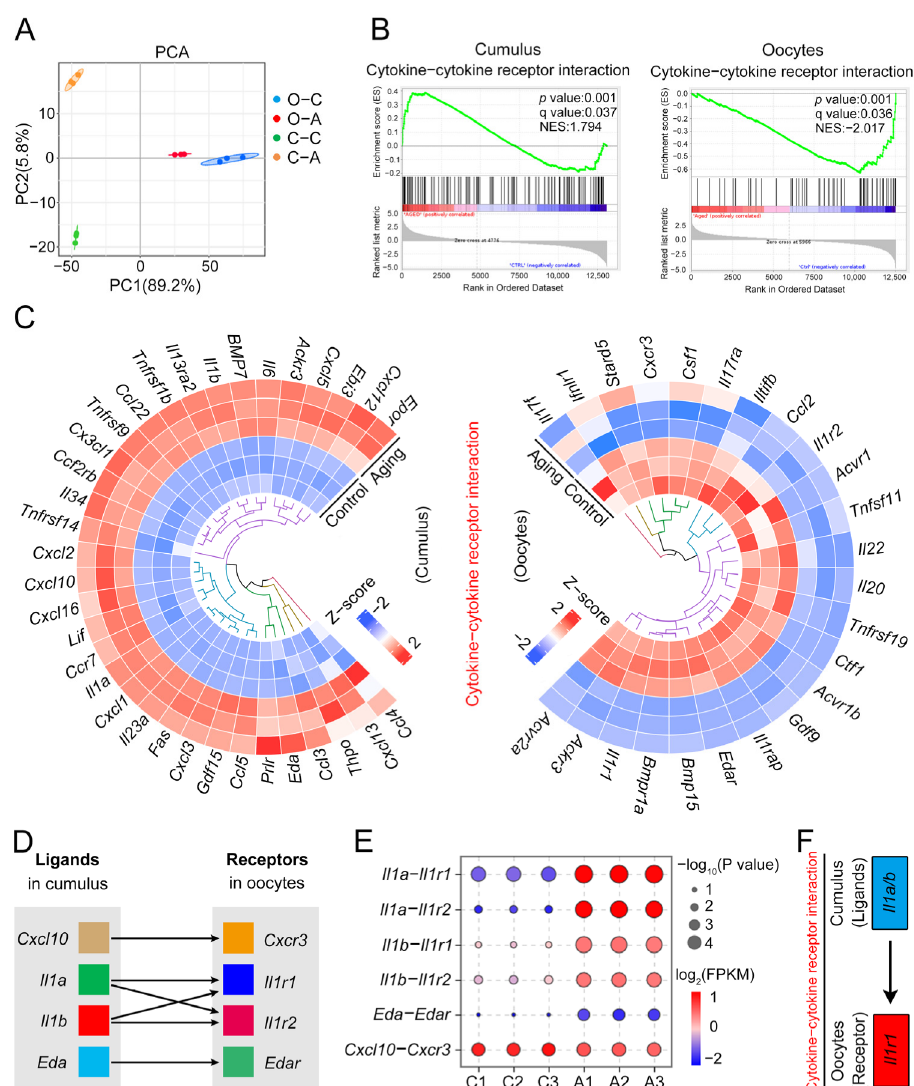
Figure 5. Il1–Il1r1 participate in interactions between the cumulus cells and oocytes. ( A ) PCA diagram combined the sample of cumulus cells and oocytes. O–C: oocytes–control group; O–A: oocytes–aging group; C–C: cumulus cells–control group; C–A: cumulus cells–aging group. ( B ) GSEA enrichment plots of cytokine–cytokine receptor interaction in cumulus cells and oocytes. ( C ) Spin diagram of related genes in the cytokine–cytokine receptor interaction in cumulus cells (left) and oocytes (right). ( D ) Cumulus cell ligand genes (left) and oocyte receptor genes (right) are paired in the cytokine–cytokine receptor interaction. ( E ) Heatmap of ligand–receptor ( Il1a–Il1r1 ; Il1b–Il1r1 ; Il1a–Il1r2 ; Il1b–Il1r2 ; Eda–Edar ; Cxcl10–Cxcr3 ) expressed in control and aging groups. C: control group; A: aging group. ( F ) The representative diagram shows ligand Il1 in cumulus cells and receptor Il1r1 in oocytes paired in the cytokine–cytokine receptor